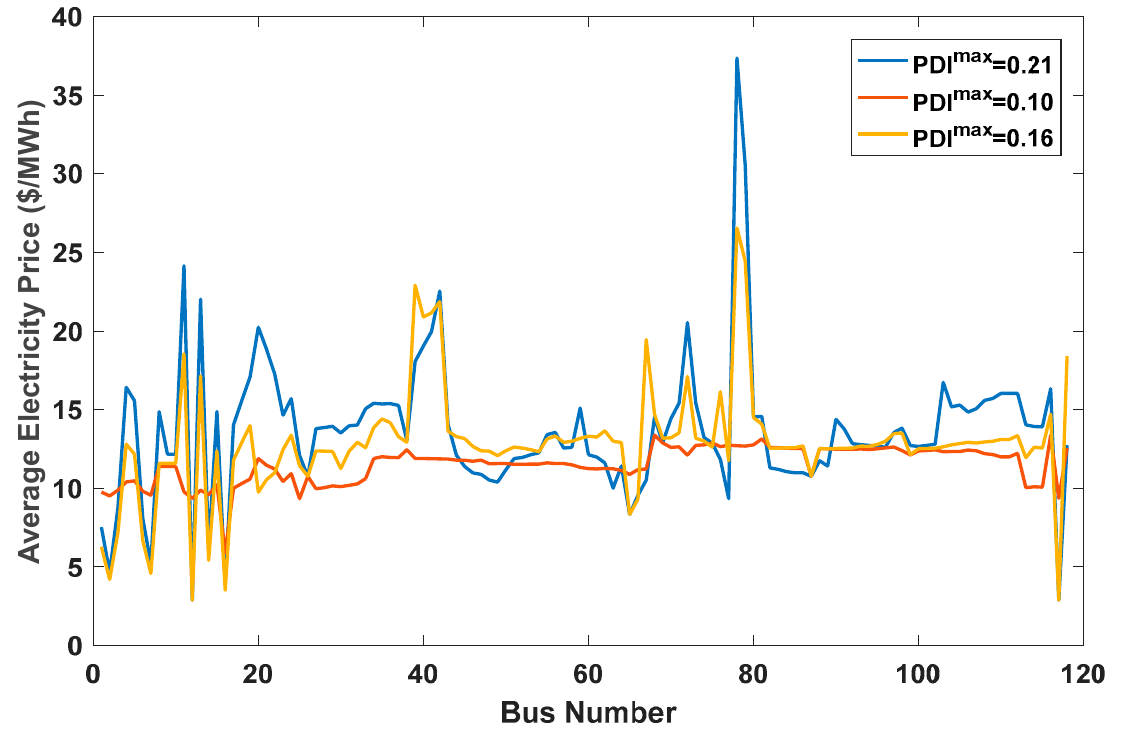
Figure 2. Average LMPs at different buses versus different values of PDI max